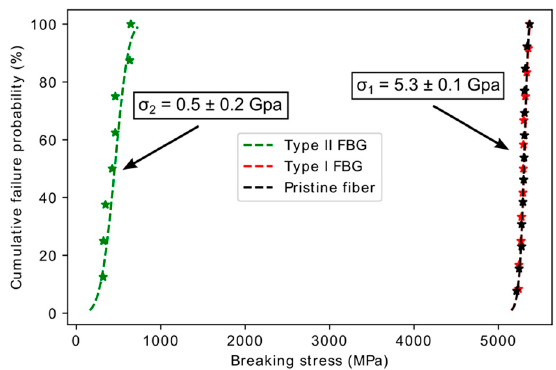
Figure 4. Comparison of the mechanical strength of pristine fiber versus type I and type II FBG written through the coating (WTC) of SMF-28 fiber. Results were partially reported in